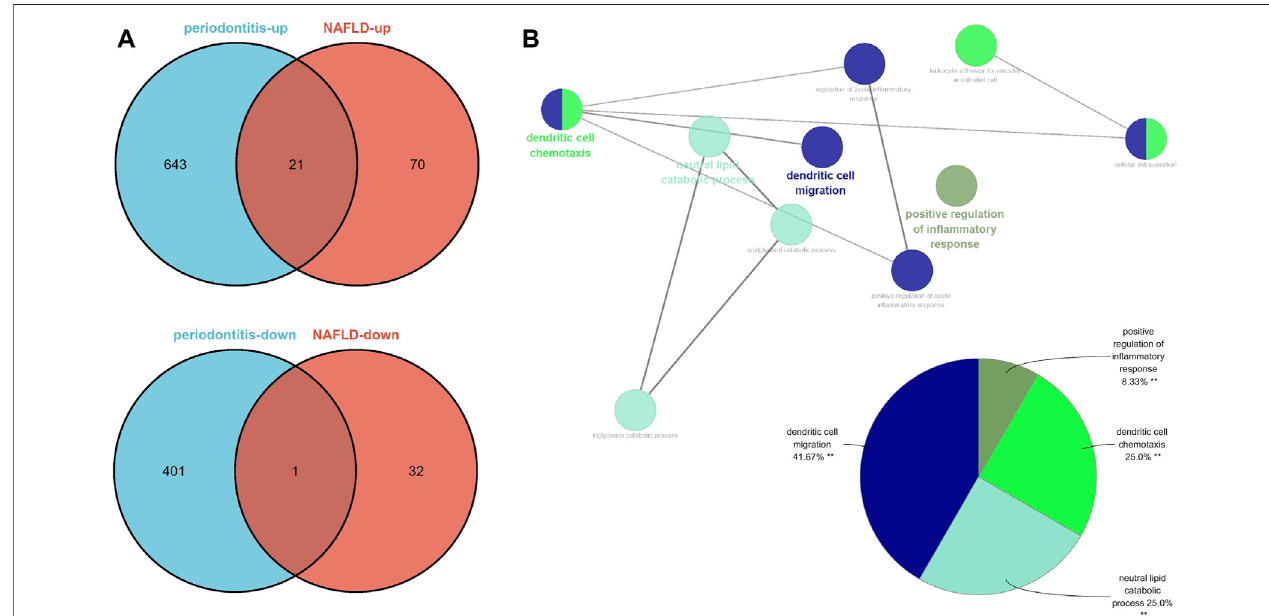
FIGURE 5 | Identi fi cation of the common DEGs and ClueGO enrichment analysis. (A) The Venn diagram of the upregulated and downregulated genes in periodontitis and NAFLD. (B) The interaction network of GO terms generated by the Cytoscape plug-in ClueGO and proportion of GO terms in the total. GO, gene ontology; NAFLD, nonalcoholic fatty liver disease. ** p <